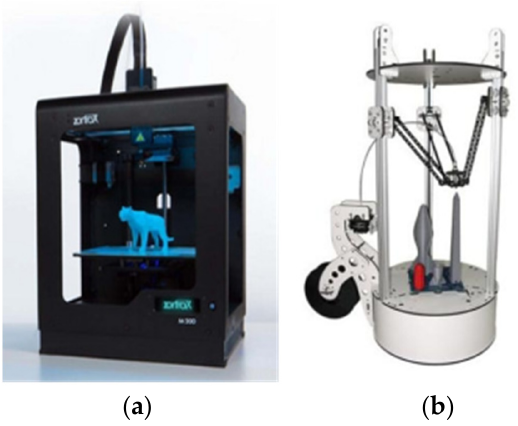
Figure 2. AM devices. ( a ) Cartesian structure; ( b ) parallel structure.